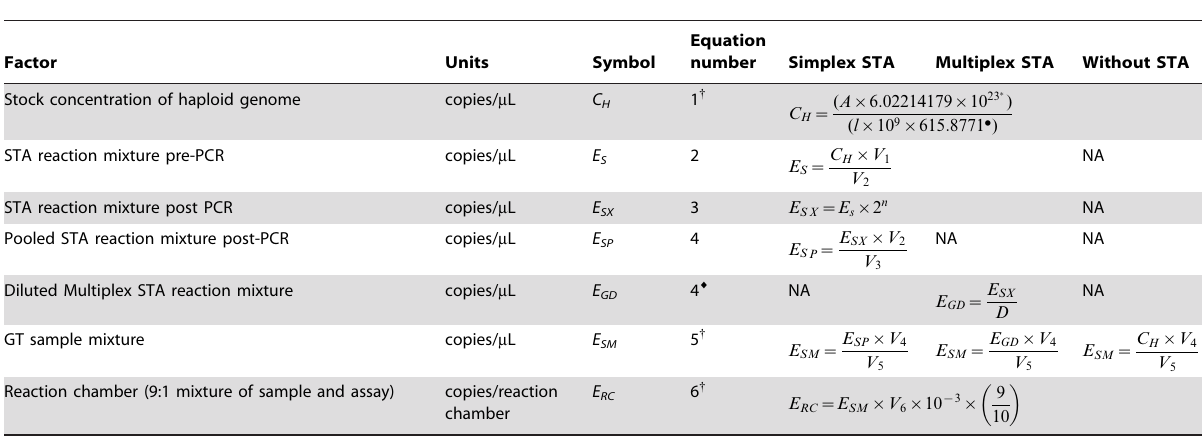
Table 1. Derivation of DNA copy number concentration in the final reaction chamber with and without